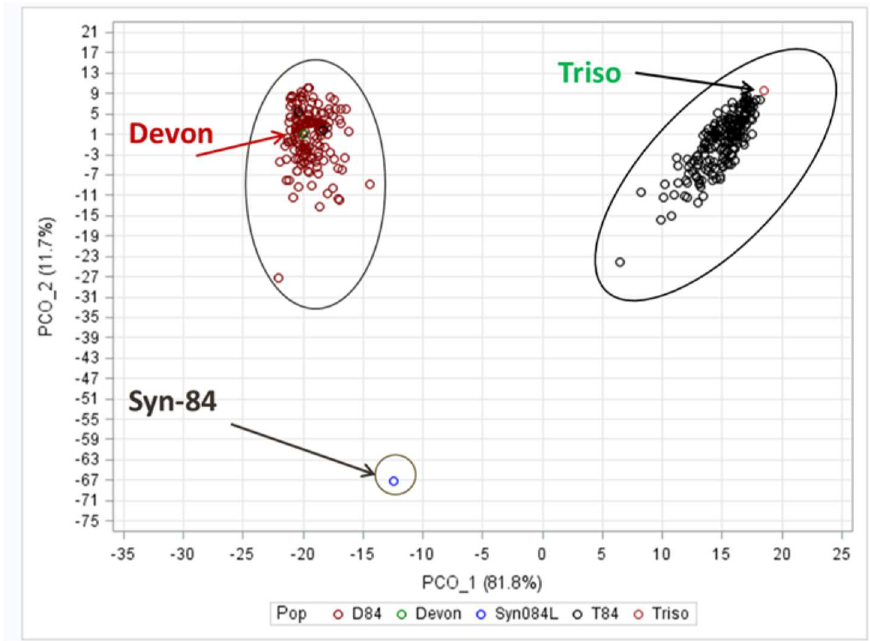
Fig 1. Principle component analysis based on calculation of genetic similarity between lines of SW84 families D84, T84 and the respective parents. D84 and T84 lines are depicted in red and black circles, respectively. The SW84 parents, Devon, Triso and Syn-84, are indicatedby arrows. The explainedvariances of the first two principlecomponentsare given in